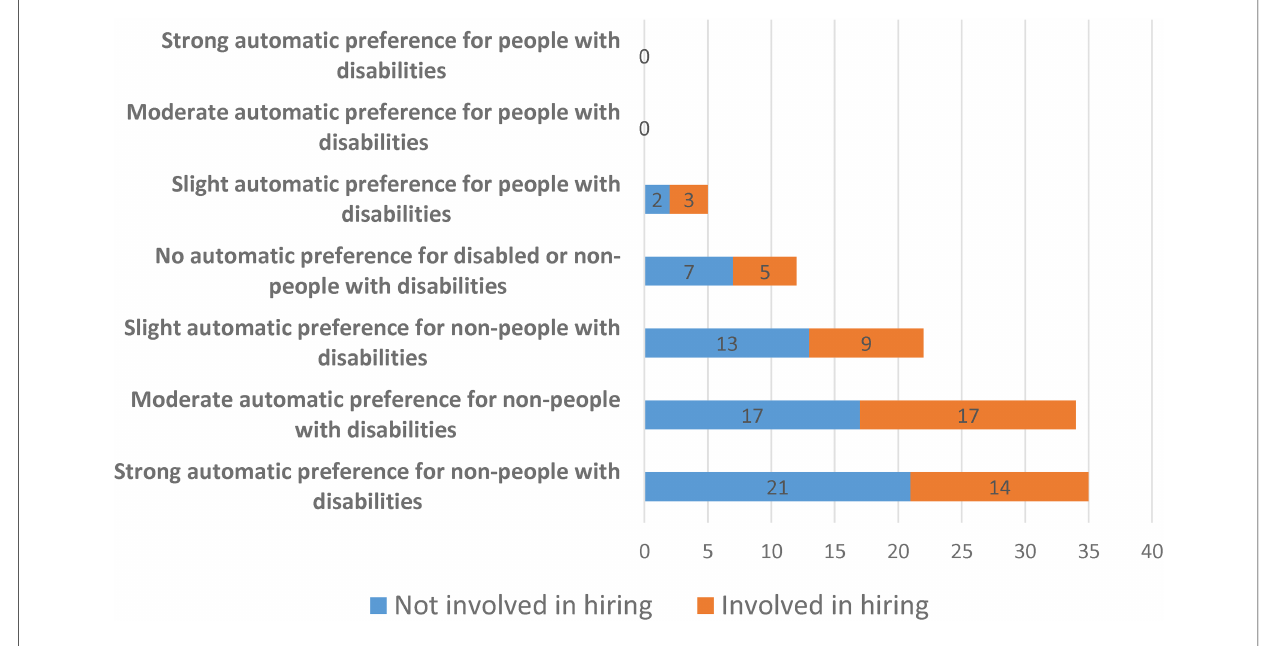
FIGURE 4 Distribution of disability IAT scores categorised by whether someone is involved in making hiring decisions or not ( N